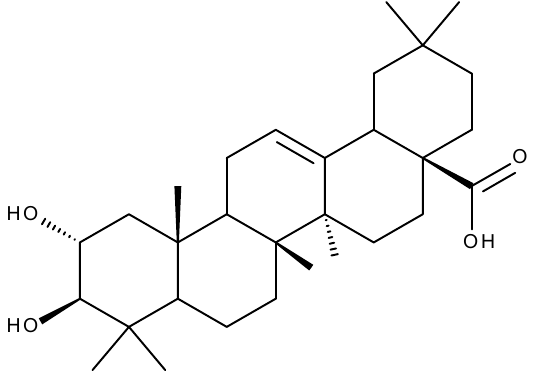
Figure 14. Structure of maslinic acid.